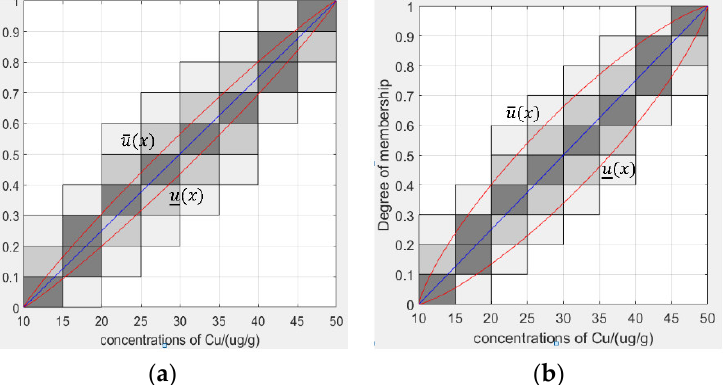
Figure 3. ( a ) Type-2 membership function when g = 1.1; ( b ) Type-2 membership function when g = 1.283.